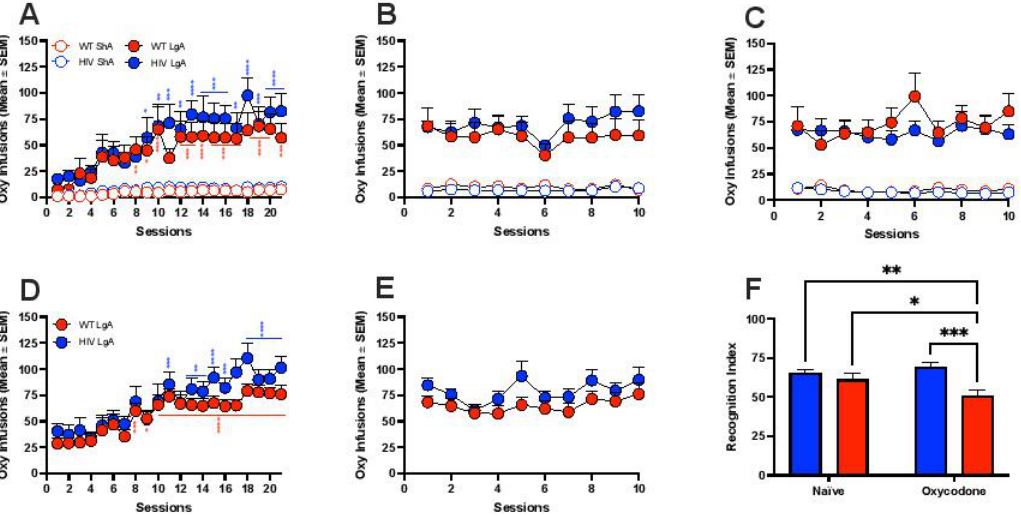
Figure 1. Intravenous oxycodone self-administration in HIV Tg rats and WT rats under nondependent (short access (ShA)) and dependent (long access (LgA)) conditions. ( A ) HIV Tg rats and WT littermates self-administering oxycodone under a fixed-ratio 1 (FR1) schedule under short-access (ShA) condi- tions in 1-h daily sessions or under long-access (LgA) conditions in 12-h daily sessions. HIV Tg rats and WT littermates escalated oxycodone self-administration under LgA conditions. Oxycodone intake did not differ between HIV Tg and WT rats under either ShA or LgA conditions. * p < 0.05, ** p < 0.005, *** p < 0.0005, **** p <0.0001 vs. Session 1 (Newman–Keuls post hoc test). ( B ) Following a pe- riod of enforced abstinence to model the intermittent pattern of opioid abuse in humans, HIV Tg and WT rats both under ShA and LgA conditions promptly resumed their previous levels of self-administration, which did not differ between genotypes. ( C ) Oxycodone self-administration under ShA and LgA conditions did not differ between genotypes after a second period of enforced abstinence. ( D ) The pattern of oxycodone self-administration in HIV Tg and WT rats under LgA conditions was highly reproducible and closely replicated in an independent set of rats. * p <